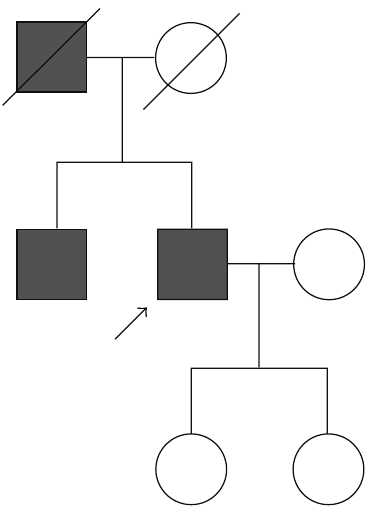
Figure 3: Pedigree of the patient’s family. Arrow indicates the patient and gray box indicates those with repeated